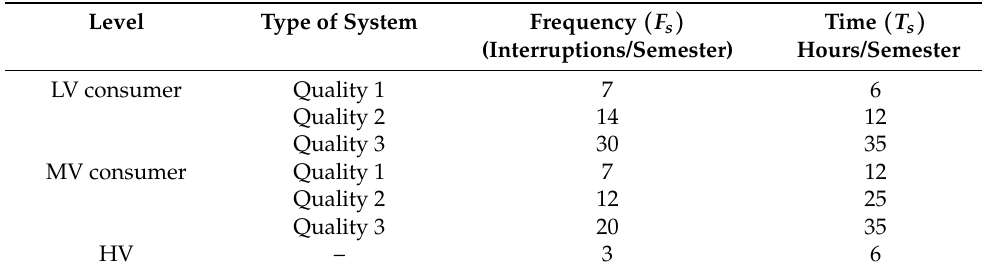
Table 3. Global and individual limits of continuity in